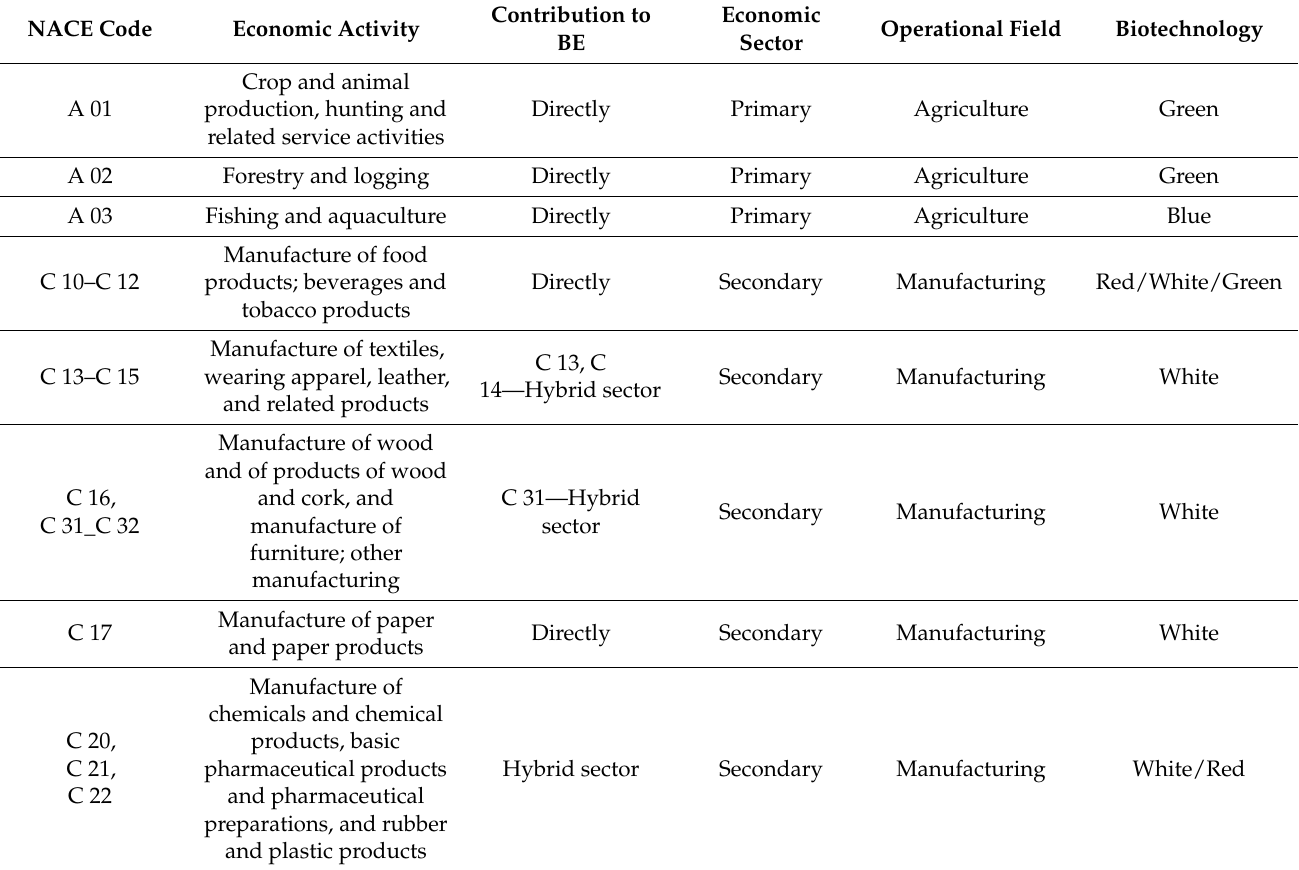
Table 1. Definition of Nordic Bioeconomy Sectors